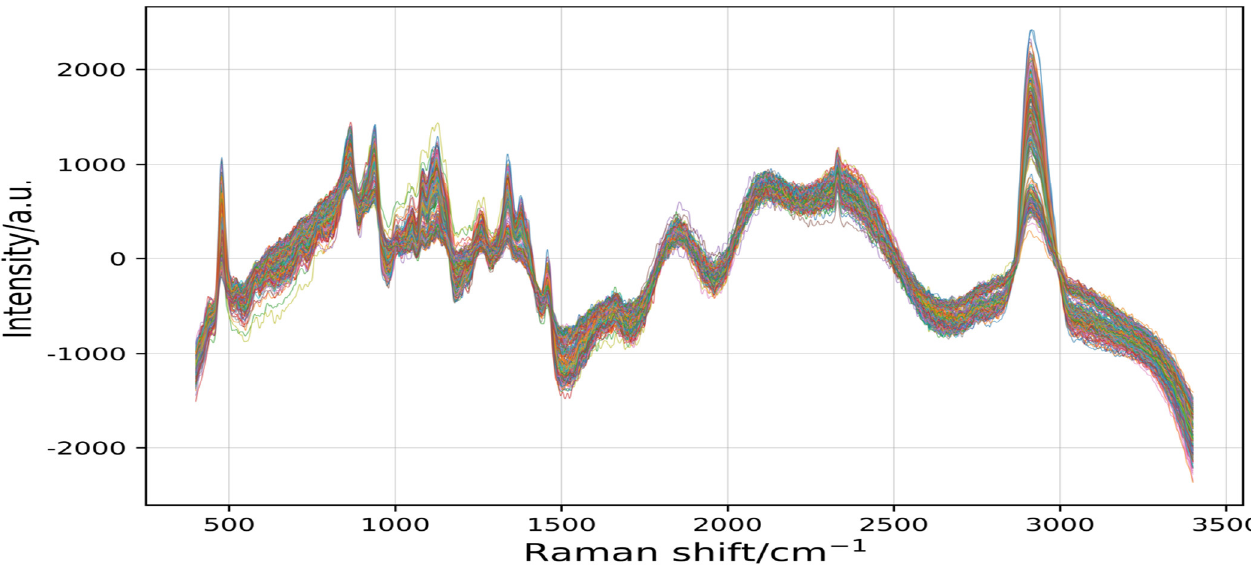
Figure 7. The curves of the peaks were filtered by the signal.filtfilt function for 245 samples. 3.2. Analysis of Selection of Effective Crest Information In this experiment, two segmentation methods and one superposition fusion method were used to convert one-dimensional data to two-dimensional data, and 245 2D data of 28 × 28 were obtained. The imshow method [50] in the Python-based matplotlib package was used to complete the data visualization (Figure 8). Two-dimensional scalar data are